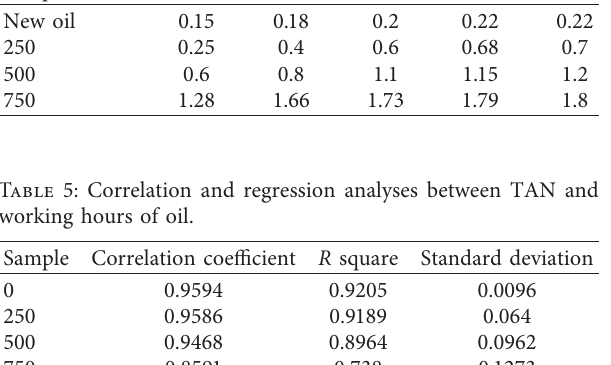
Table 4: Experimental readings of TAN. Sample (hrs)